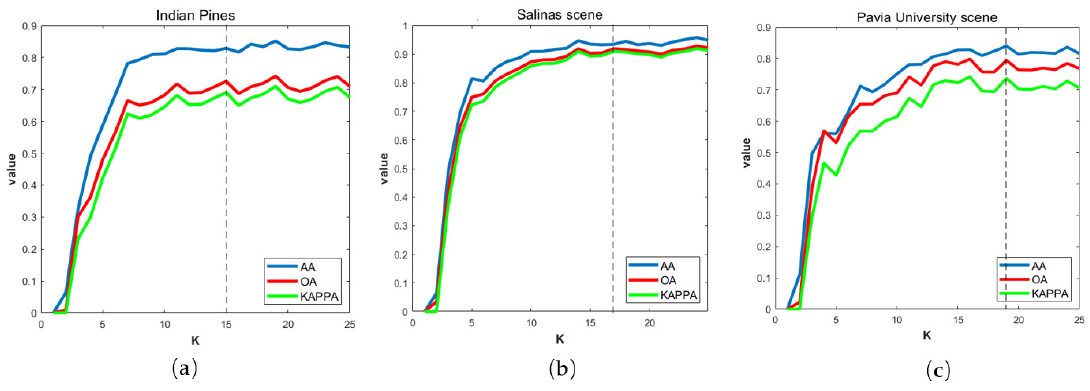
Figure 5. E ff ect of using di ff erent k in the classification of di ff erent datasets. ( a ) Indian Pines; ( b ) Salinas Figure 5. Effect of using different k in the classification of different datasets. ( a ) Indian Pines; ( b ) scene; ( c ) Pavia University Salinas scene; ( c ). Pavia University scene.